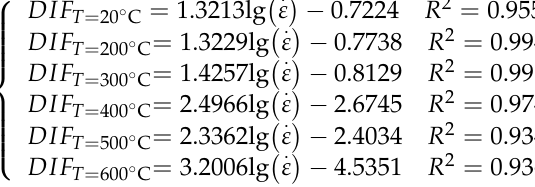
Figure 9. Relationship between DIF and lg(cid:4666)𝜀(cid:4662)(cid:4667) at different temperatures